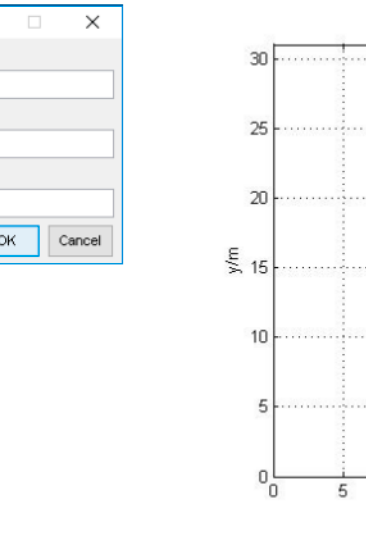
Figure 12. Simulation result when the RSSI values are − 44.7318, − 50.7564, and − 54.9525 (dBm) for the three points (a, b, and c).